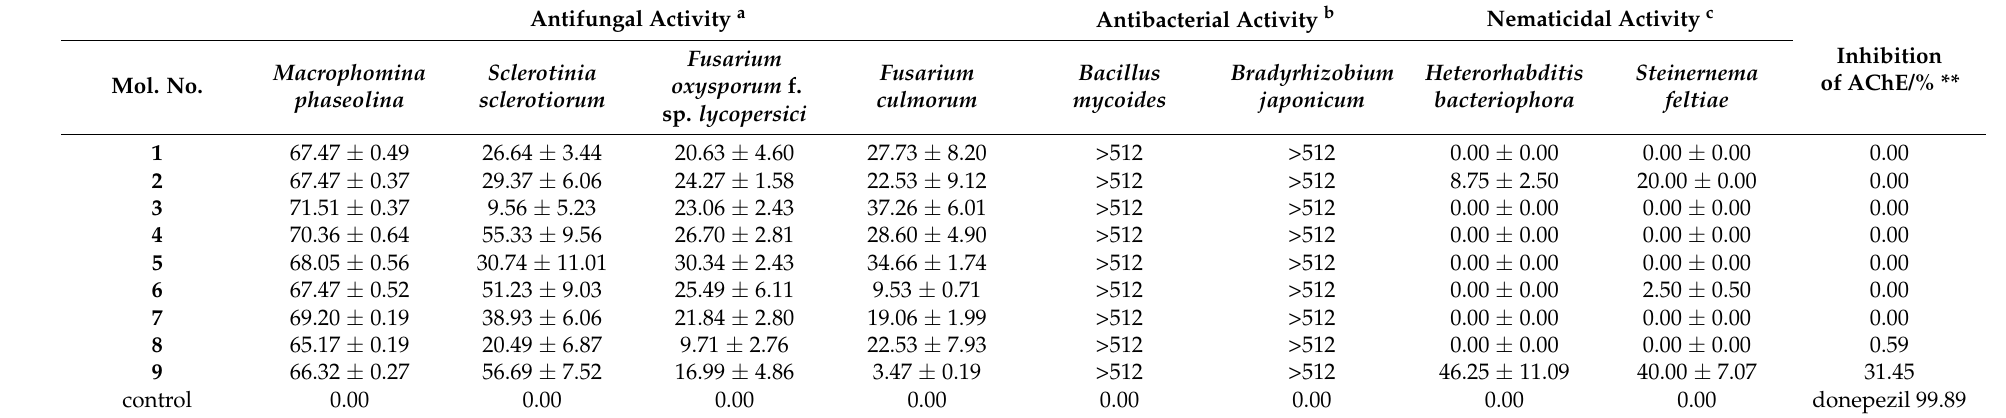
Table 2. Results of biological activity assays of nine coumarinyl Schiff bases: a inhibition rate %, 48 h after inoculation at the concentration 0.08 µ mol/mL; b minimum inhibitory concentration (MIC/ µ g mL − 1 ; c percentage corrected mortality, %, 48 h after inoculation at the concentration 500 µ g/mL), and acetylcholinesterase (AChE) inhibition